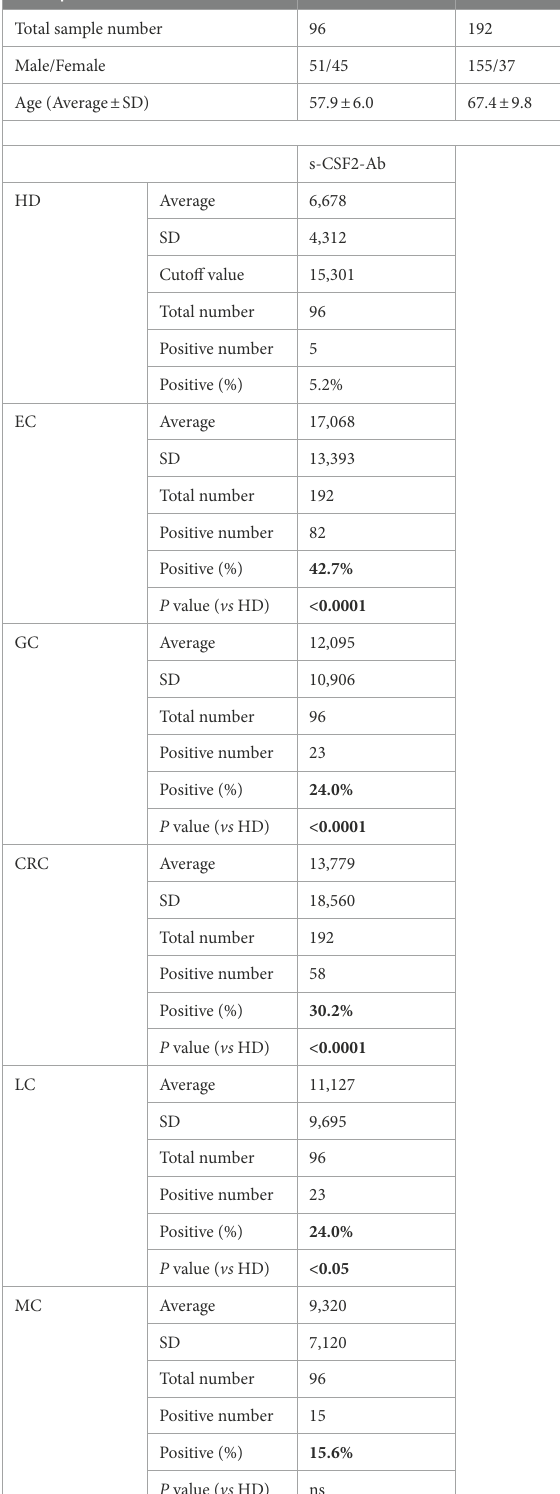
TABLE 7 Association of s-CSF2-Ab levels with cancer development. Sample